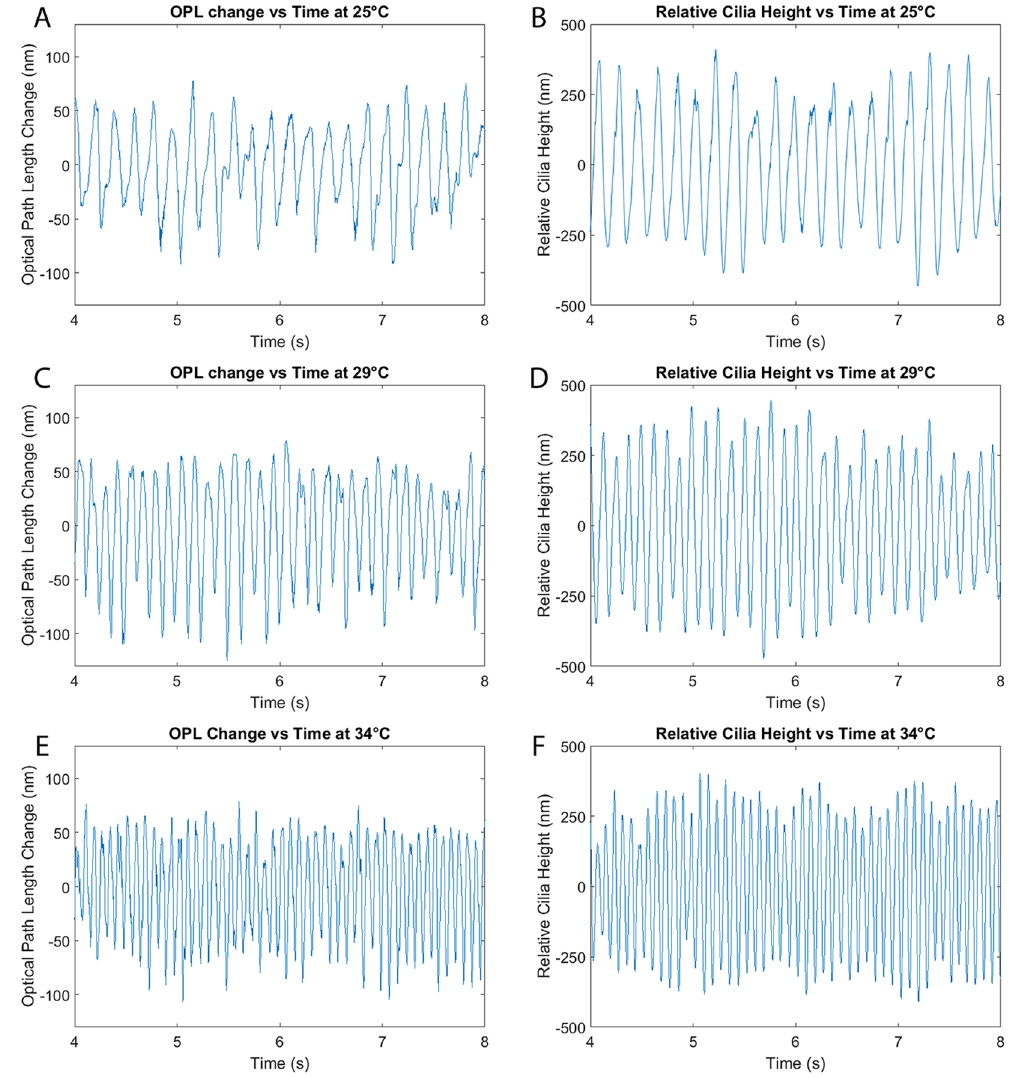
Figure 6. Axial displacement of cilia between sequential time points at 25 °C, 29 °C, and 34 °C ( A , C , E ). Time integration of axial displacement showing temporal measurements of cilia height at 25 °C, 29 °C, and 34 °C ( B , D , F